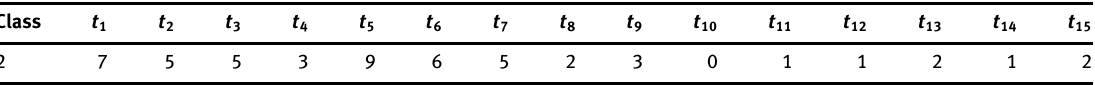
Table 3: Computation of ClassTermFrequency for Class